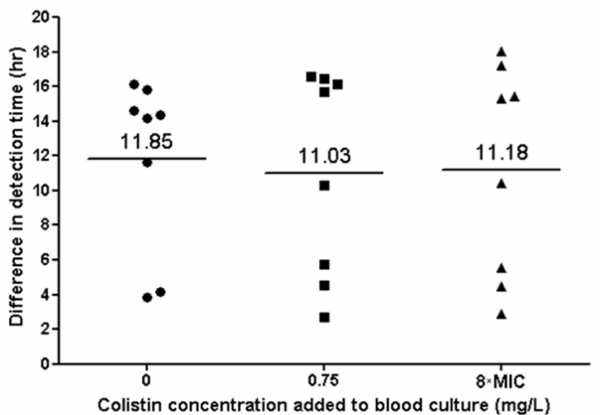
Figure 5. Bacterial growth in blood culture of eight colistin-dependent isolates. Each black dot represents the difference in TTD between the CD strain and its parent strain. The lines represent the average difference at each colistin